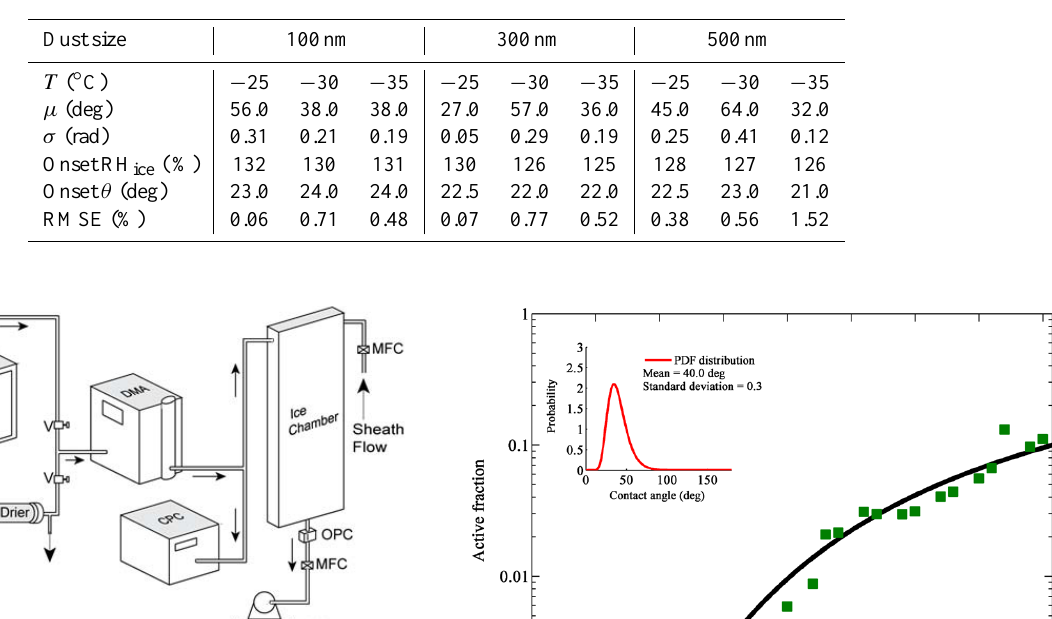
Table 1. PDF parameters, onset ice nucleation conditions and RMSE obtained for ATD. One experiment was performed at each temperature and dust size. The range of onset single contact angle ( θ ) variation was minimum compared to the µ parameter. The uncertainty errors for µ and σ are ± 3.0 deg and ± 0.04 rad, respectively.